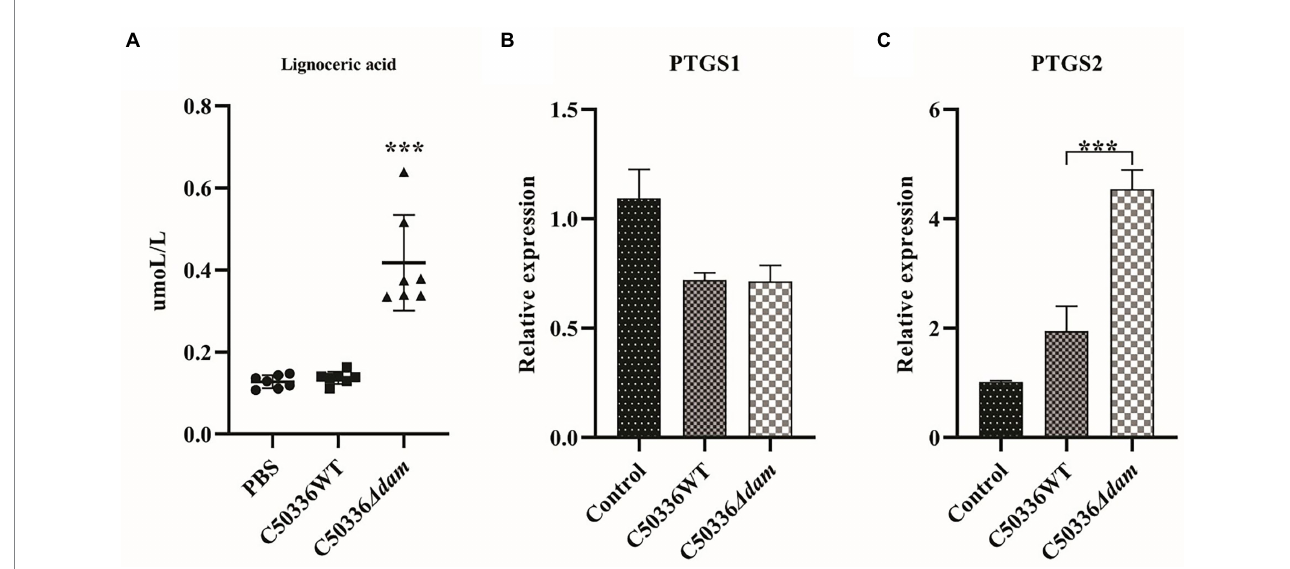
FIGURE 6 The dam gene can inhibit the alternative pathway of intracellular AA synthesis and the transcription of COX-2. (A) Quantitative results for ion-targeted metabolomics of tetracosanoic acid metabolites. The circle in the Figure is the PBS treatment group, the square is the C50336WT treatment group, and the triangle is the C50336 Δ dam treatment group, and each graphics is the quantitative analysis result of a single sample. *** p < 0.001 for one-way ANOVA followed by Bonferroni’s multiple comparison test. Data were presented as mean ± SEM ( n = 7). (B) Relative expression levels of COX-1related gene ptgs1 . (C) Relative expression levels of COX-2 related gene ptgs2 . *** p < 0.001 for one-way ANOVA followed by Bonferroni’s multiple comparison test. Data were presented as mean ± SEM of triplicate samples per experimental condition from three independent